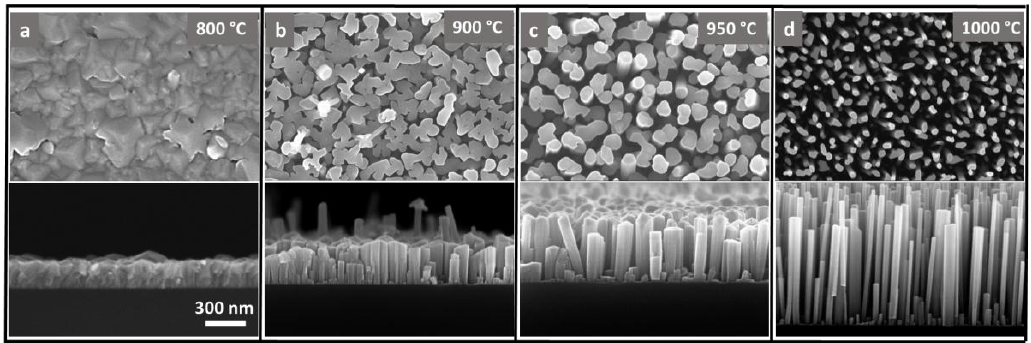
Figure 1. Top-(up) and cross-sectional (bottom) view SEM images of GaN NRs grown on Si at different temperatures: ( a ) 800 °C, ( b ) 900 °C, ( c ) 950 °C, and ( d ) 1000 °C. The same scale applies to all images.